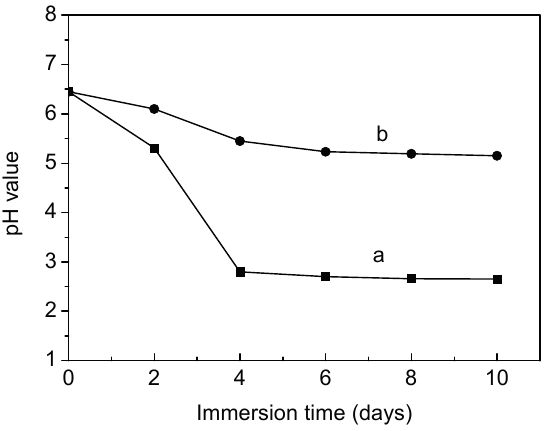
Figure 8. The pH change of medium as a function of time during degradation of (a) PLA and (b) collagen-PLA.